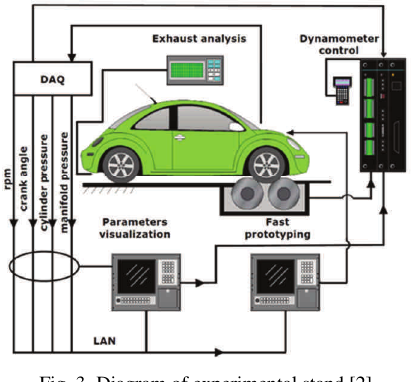
Fig. 3. Diagram of experimental stand [2]